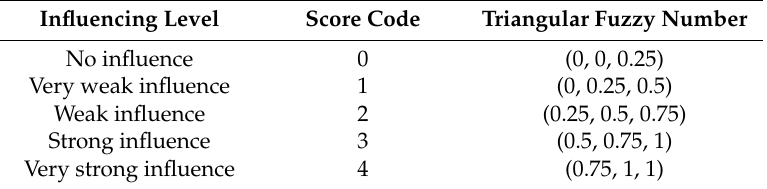
Table 1. Triangular fuzzy numbers.